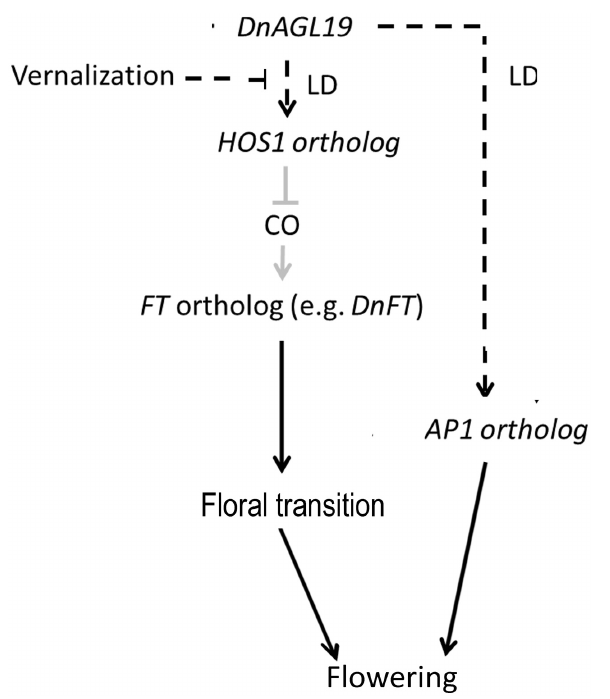
FIGURE 6 | A predicted model of the gene regulation network (GRN) involving DnAGL19 to control D. nobile flowering. High levels of DnAGL19 expression regulate flowering via FT -dependent and AP1 -dependent pathways which are independent from each other. In the FT -dependent pathway, the HOS1-CO module responds to the environmental temperature cues to differentially regulate the expression of FT ortholog. Under conditions with higher environmental temperature (e.g., in spring), expression of HOS1 is activated by DnAGL19 and therefore results to down-regulation of FT ortholog probably duo to degradation of CO protein. In winter with long-term low temperature, the activation of HOS1 is suppressed and the FT ortholog is up-regulated, by which floral transition is promoted. On the other hand, activated expression of DnAGL19 also results in up-regulation of AP1 ortholog to promote the establishment of floral meristem identity, but the components upstream and/or downstream the AP1 ortholog remains to be clarified. The black solid lines indicate that the D. nobile orthologs of FT and AP1 have been verified to be functional in flowering regulation. The HOS1-CO-FT module (shown with gray solid lines) has been identified in A. thaliana (Jung et al., 2012; Lazaro et al., 2012) but has yet to be characterized in D. nobile . The black dashed lines show the regulations observed at the transcriptional